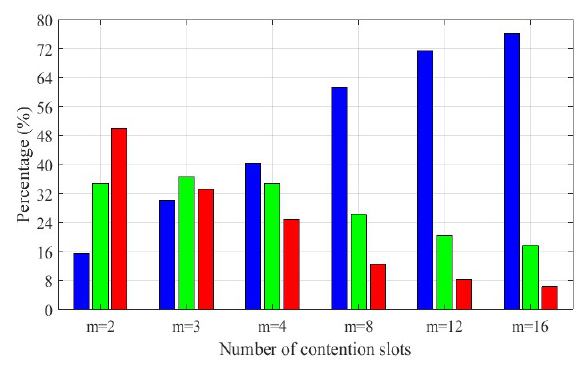
Figure 7. Average number of empty (blue), successful (green) and collided (red) contention slots during the collision resolution